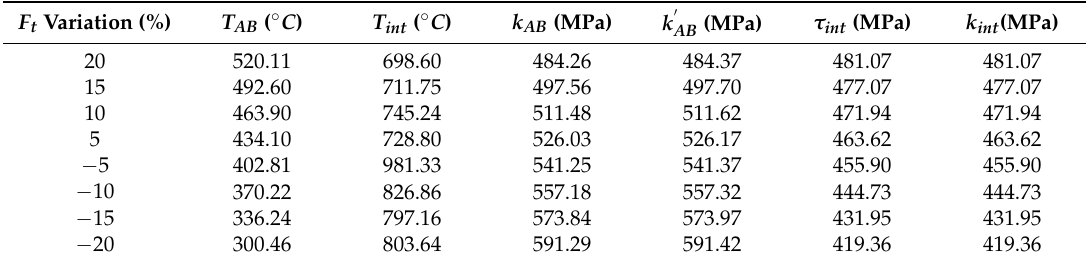
Table A2. Variables in sensitivity analysis of thrust force under test 1 cutting